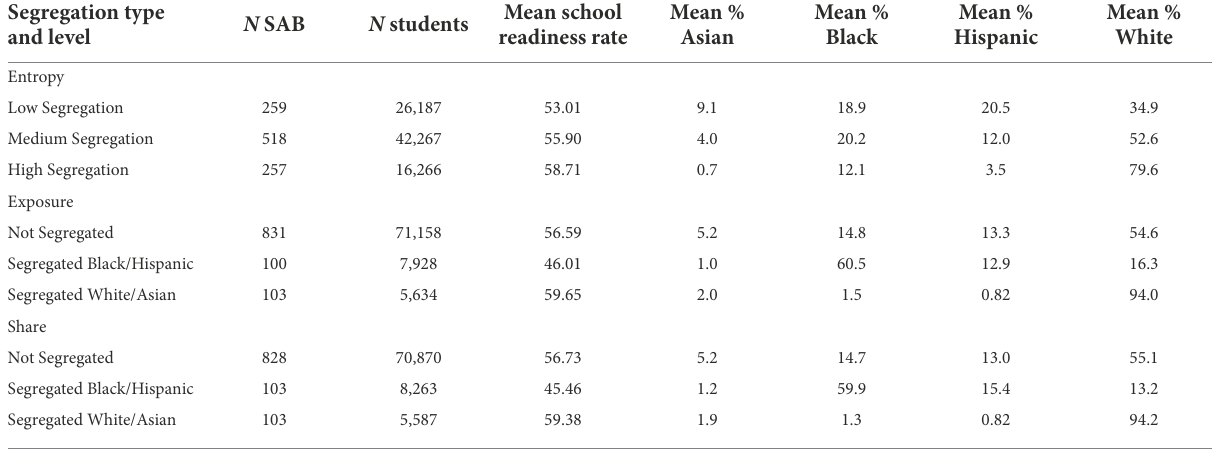
TABLE 2 School readiness rate and student race and ethnicity by segregation type and level. Segregation type and